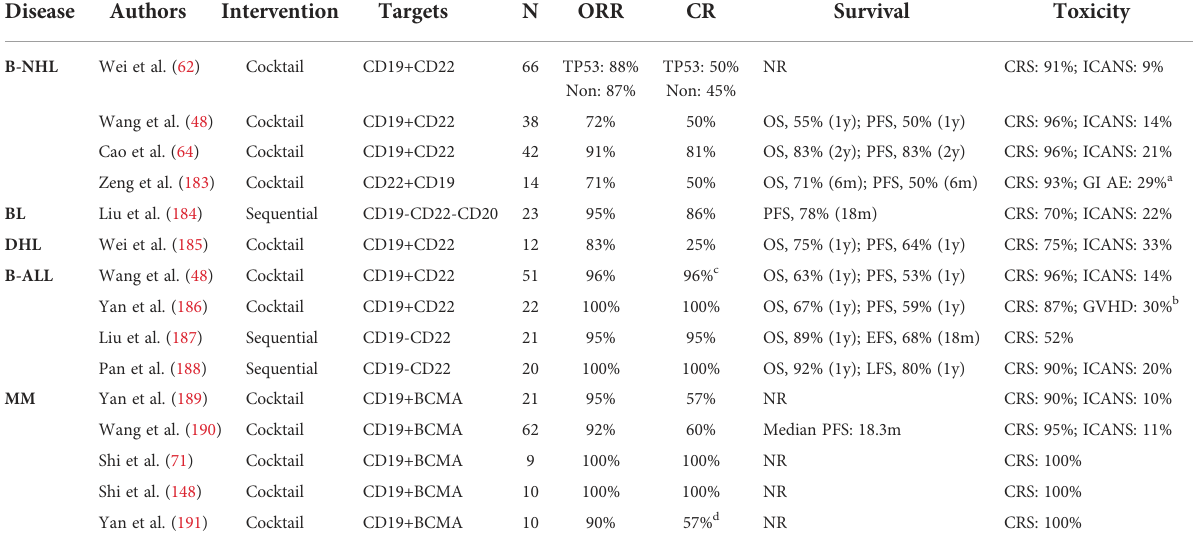
TABLE 4 Clinical trials of CAR T cell cocktail or sequential therapy. Disease